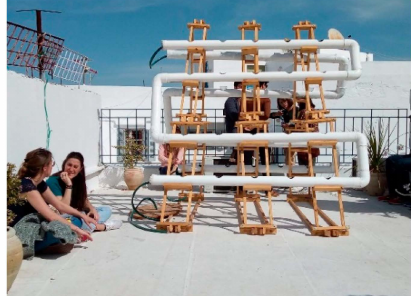
Figure 13. The project idea “Jnina Fel Medina” in a House rooftop in Hafsia quarter in the Medina of Tunis (data source: Faika Bejaoui (one of the project initiators photography). For the case of Marrakesh, environmental actions aimed to ensure increasing sustain- ability for the future. Green spaces inside the Medina impacted by urban pressure needed protection and consideration. The Global Diversity Foundation has launched the initiative “For More Green Spaces in the Medina” to ensure the conservation of Medina’s remaining trees. Several environmental and conservation projects carried out in Marrakesh increased urban ecological quality. The Urban Garden Project of the Ibn Abi Sofra School, located in an old, abandoned Agdal Bahmed Garden, involved different associations that collabo- rated to restore orchards and gardens over a one-hectare area [35] (pp. 1–31). These initiatives should undoubtedly be reinforced and encouraged. On the other hand, stakeholders, local and governmental organisms are important actors in green in- frastructure planning because that could involve new planning processes, knowledge, and other resources [10]. However, these initiatives are not well involved under official conceptualized regional schemes, and need to be strengthened by a theoretical frame- work. 5.3 Research-Based Design for Urban Livability Improvement There are several key concepts in the application of UGI; however, the idea is rela- tively new [43]. In the case of historic dense fabrics, the application of this approach should be tested. To illustrate the ideas that have been concluded from this study, an area from the northern part of the historical core of the Medina of Tunis was selected to define potential sites for green implementations. The study suggests to implement design based concepts in the sample area. The chosen section is in direct continuity with one of the most fre- quently visited circuits. Moreover, it is near the peripheral quarters of the Medina (El Hafsia), which represents a transition between the European and Islamic parts of the Tu- nis city. In the study area, several landscape elements which have the potential to host green elements were detected too (public squares, streets with various scales, and a pri- vate neglected educational institution).